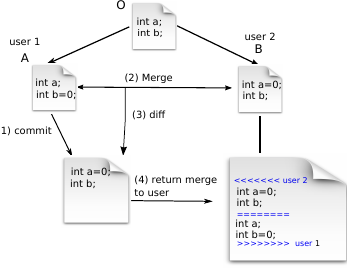
Figure 1. Conflict in state-based systems for